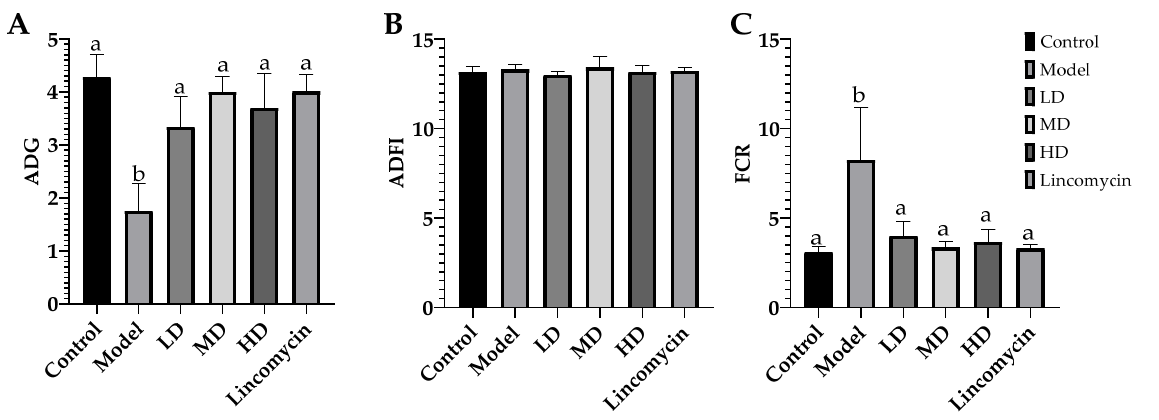
Figure 3. Comparison of the growth performance. ( A ) ADG; ( B ) ADFI; ( C ) FCR. Values with the same superscript letters in the same line were not significantly different ( p > 0.05); values with different letters were significantly different ( p < 0.05).